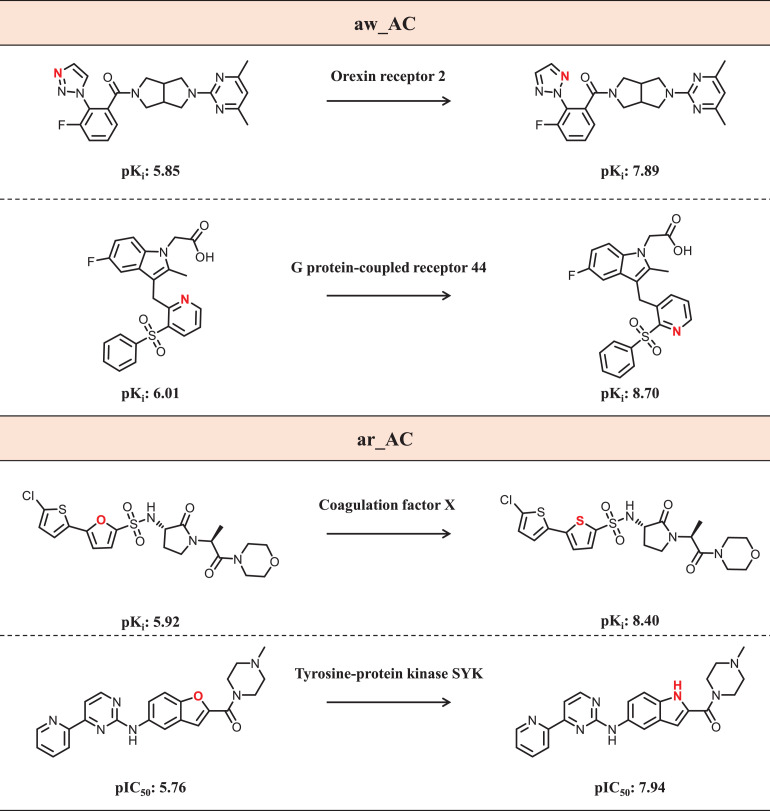
Shown are exemplary aw_ACs (top) and ar_ACs (bottom), respectively. Modified atoms are colored red. For each AC, the target and negative decadic logarithmic compound potency values (pKi or pIC50) are reported.